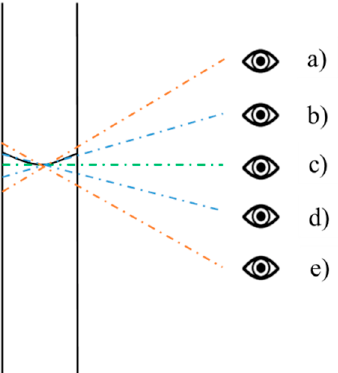
Figure 2. Readings of a concave surface from different view angles, including ( a ) outside of readings of a concave surface, ( b ) looking down, ( c ) same horizontal height as the eye, ( d ) looking up, ( e ) outside of readings of a concave surface.